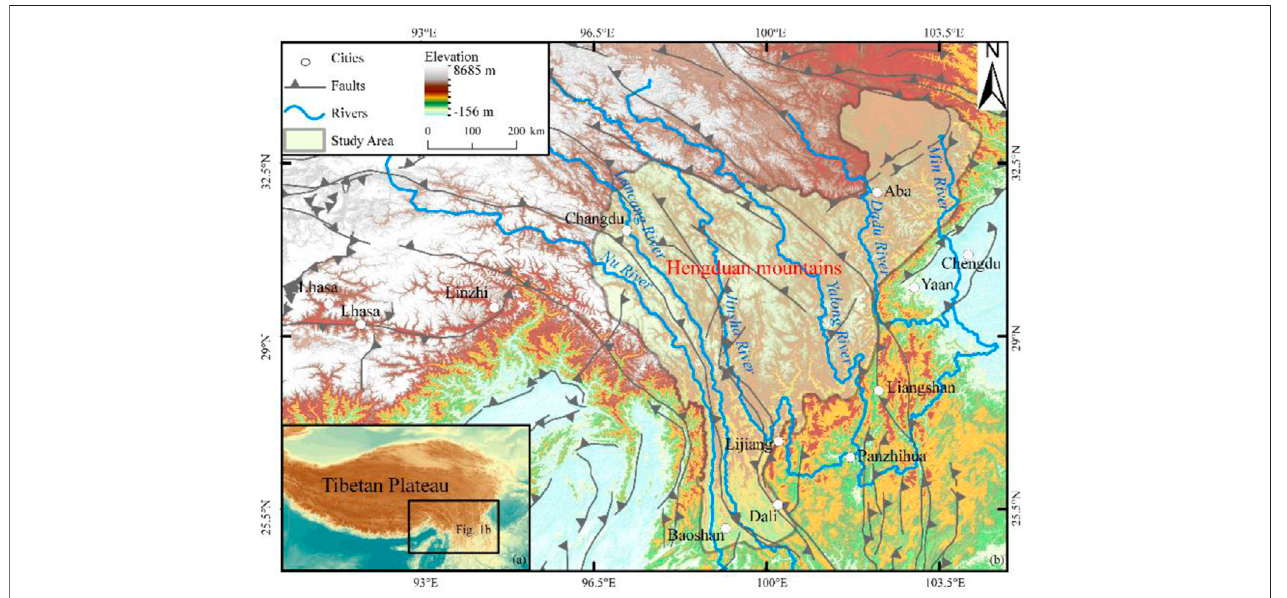
FIGURE 1 | Overview of the southeastern Tibetan Plateau. The fault locations are from the study by Taylor and Yin (2009).